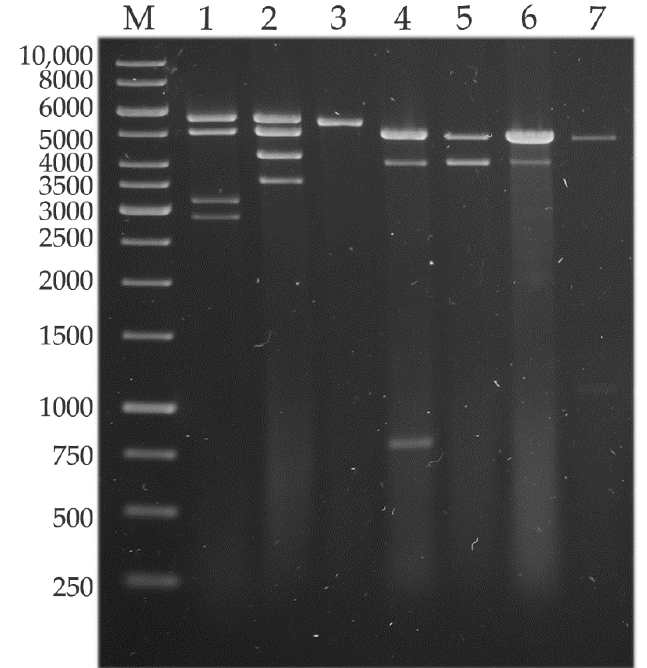
Figure 1. Gel electrophoresis pattern of the detected dsRNA genomes in seven mycovirus-harboring Umbelopsis strains. Lane M, GeneRuler 1 kb DNA Ladder (Thermo Scientific); Lane 1, Umbelopsis ramanniana NRRL 1296; Lane 2, Umbelopsis ramanniana CBS 478.63; Lane 3, Umbelopsis ramanniana CBS 243.58; Lane 4, Umbelopsis gibberispora CBS 109328; Lane 5, Umbelopsis angularis CBS 603.68; Lane 6, Umbelopsis dimorpha CBS 110039; Lane 7, Umbelopsis versiformis CBS 473.74.